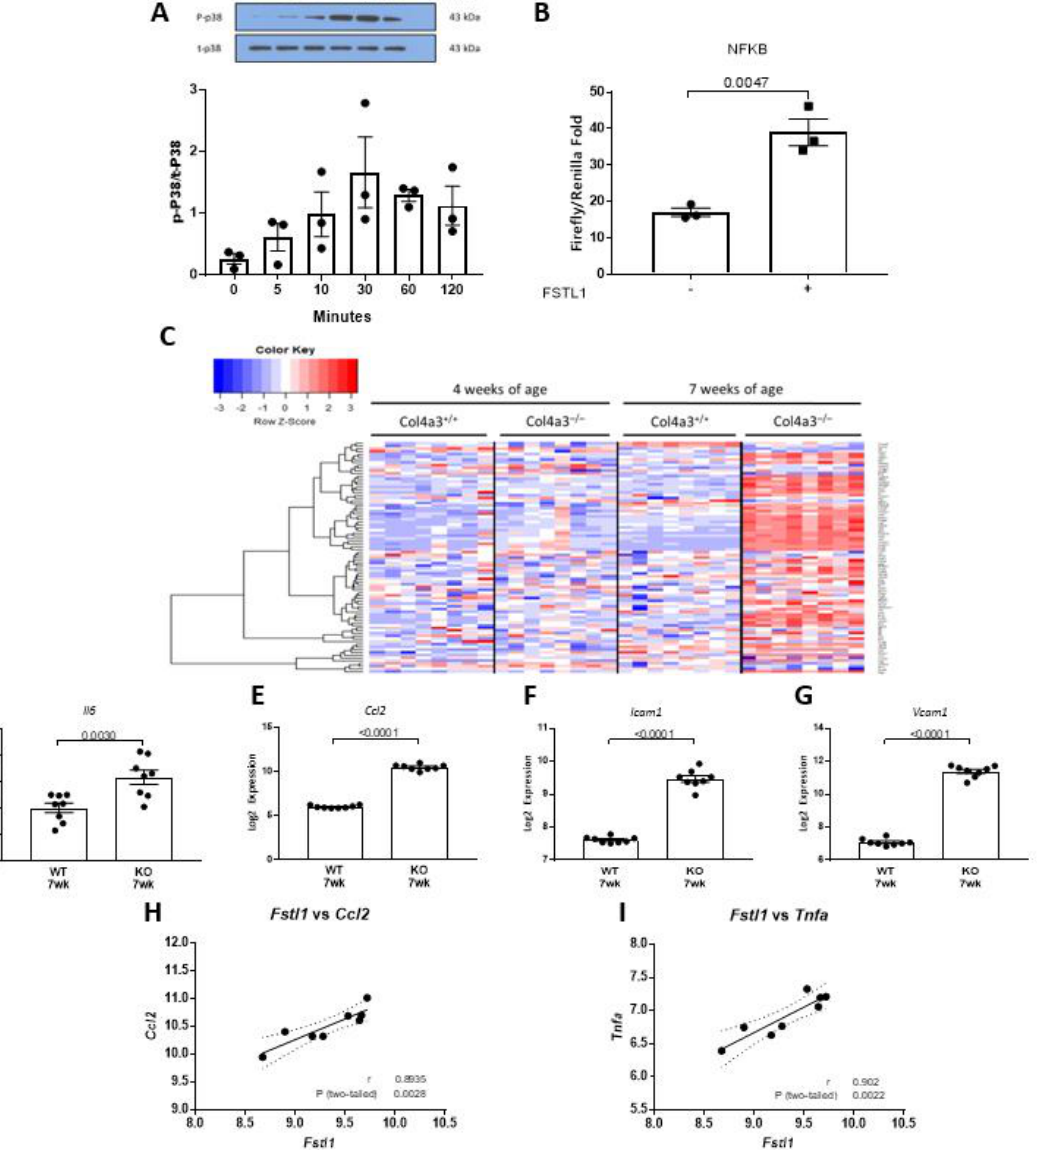
Figure 11. p38 MAPK activation and NF κ B-related expression. ( A ) Representative immunoblots for phosphorylated (P-p38) and total (t-p38) p38 in immortalized human proximal tubule epithelial cells that were treated with rhFSTL1 for either 0, 5, 10, 30, 60, or 120 min. Densitometry intensities were quantified and normalized to total p38 ( n = 3). Values are mean ± SEM, and P values were determined by one-way ANOVA. Significance was defined as a p value of < 0.05. ( B ) Immortalized human proximal tubule epithelial cells were transfected with an NFκB luciferase reporter plasmid. Cells were incubated in rhFSTL1 for 24 h ( n = 3 per group) and luciferase activity was determined. Values are the mean ± SEM (black bars). Significance was defined as a p value of < 0.05. ( C ) Heatmap with unsupervised hierarchical cluster analysis of NFκB related genes in kidneys of 4 and 7 week old Col4a3 –/– and wild-type mice ( n = 8 per group). ( D – G ) Graphical representation of selected gene mRNA levels in 7 week old wild type versus 7 week old Col4a3 –/– mice. Values are the mean ± SEM (black bars). p values were determined by Student’s t tests, and significance was defined as a p value <0.05. ( H , I ) Fstl1 mRNA levels were correlated with Ccl2 and Tnfa mRNA levels. Pearson’s correlation coefficient ( r ) was determined, and two-tailed p values derived. Linear regression generated the line of best fit (solid lines) with 95% confidence intervals (dotted lines). Significance was defined as a p value < 0.05.